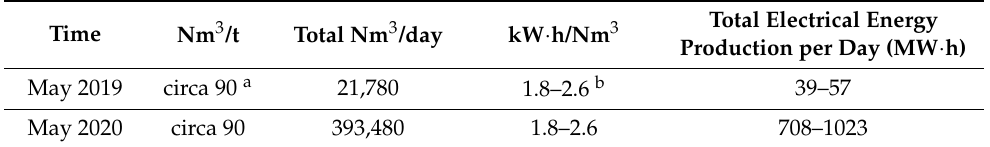
Table 3. Energy production per day from AD of food waste showing approximately 60% increase from before to after the July 2019